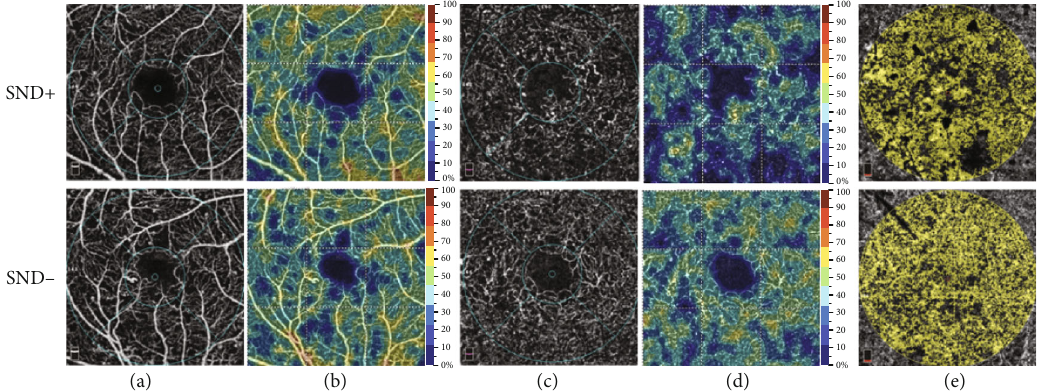
Figure 2: Representative samples of the foveal microvascular parameters for the eyes with and without subfoveal neuroretinal detachment (SND): (a) shows the parafoveal vessel density in the super fi cial capillary plexus (SCP); (b) shows the vessel density in the SCP using color maps; (c) shows the parafoveal vessel density in the deep capillary plexus (DCP); (d) shows the vessel density in the DCP using color maps; (e) shows vessel density in the choriocapillary